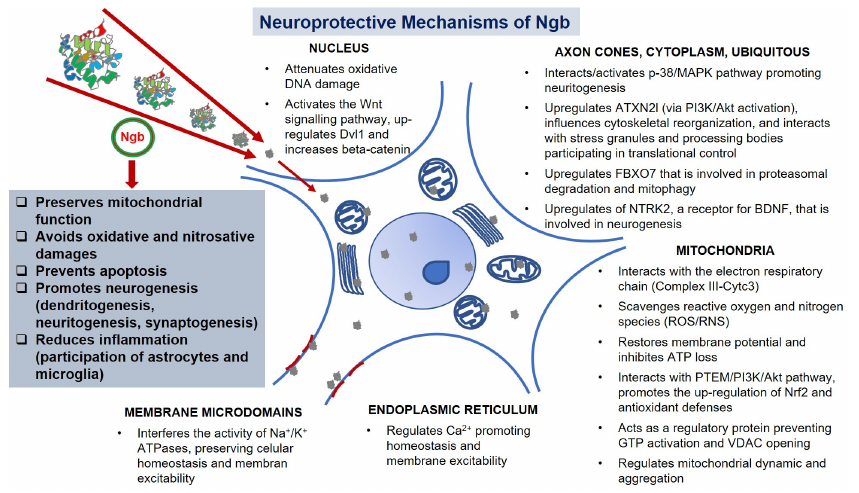
Figure 3. Neuroprotective mechanisms of Ngb. Neuroprotective protein Ngb enhances neuroregen- eration by interfering in different processes and molecular pathways involved in neurogenesis and neuronal network